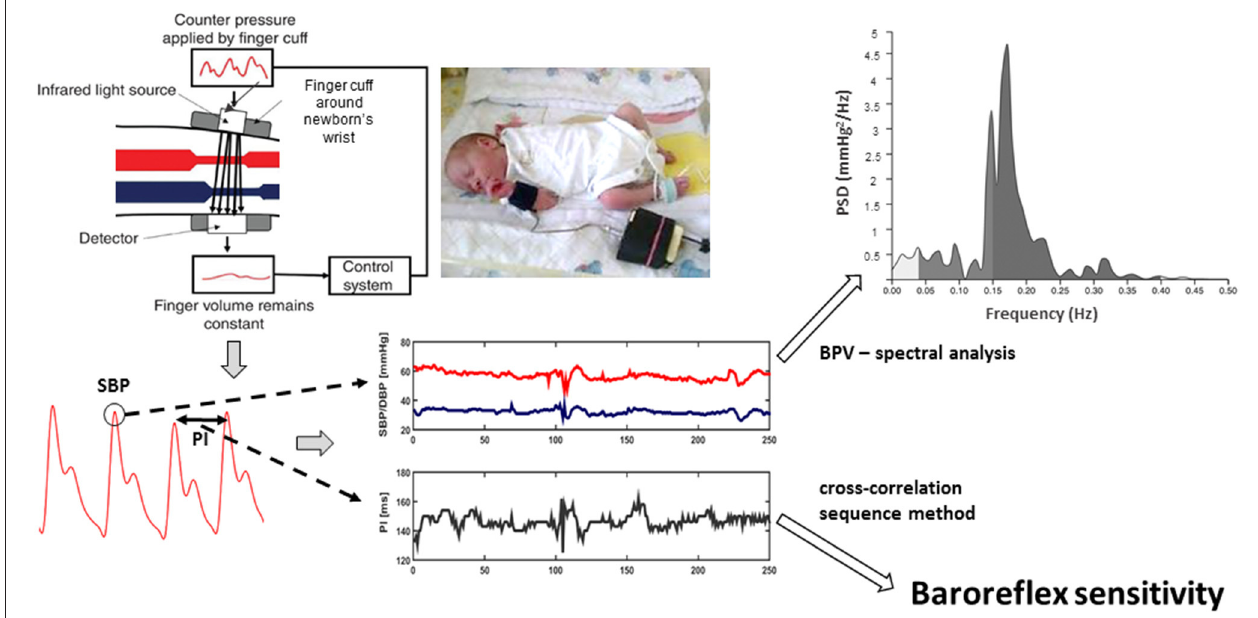
FIGURE 1 | Volume-clamp photoplethysmographic method of peripheral blood pressure measurement (upper left part) is based on the application of counter pressure by cuff (in adults applied on finger, in newborns on wrist) to prevent pulsations in finger (or wrist) volume caused by blood pressure oscillations, including pulses related to heart beat. It is verified that cuff pressure then corresponds to arterial blood pressure. From the resulting recording (left bottom part of figure), systolic blood pressure (SBP) values and pulse intervals (PI) are measured. SBP oscillations (blood pressure variability) are analyzed by spectral analysis to quantify magnitude of blood pressure variability at various frequencies [e.g., in low (0.04–0.15Hz) and high (0.4–1.5Hz) frequency bands]. In addition, baroreflex sensitivity is quantified from the correlation between two measured signals (SBP and PI oscillations) using cross-correlation sequence